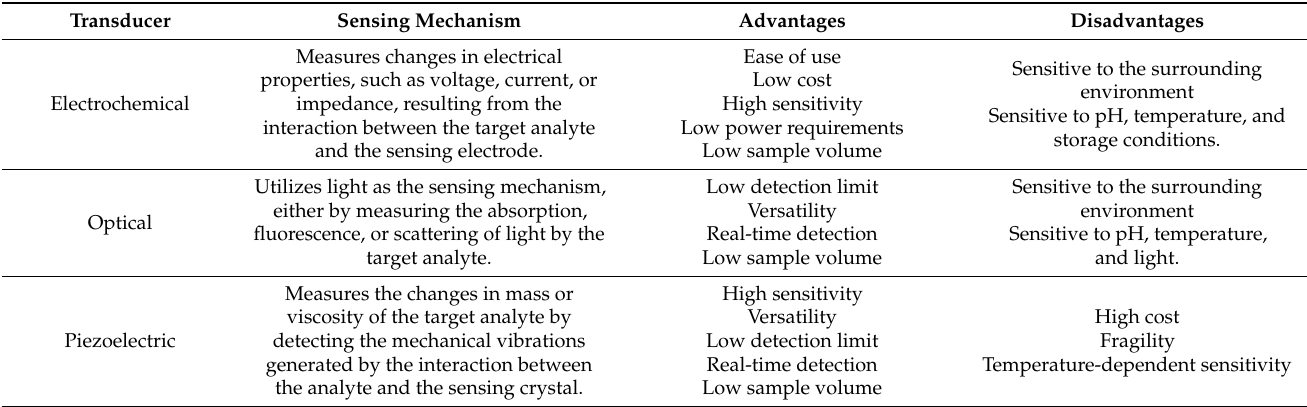
Table 2. Summary of the transducer mechanisms used in biosensing and their advantages and